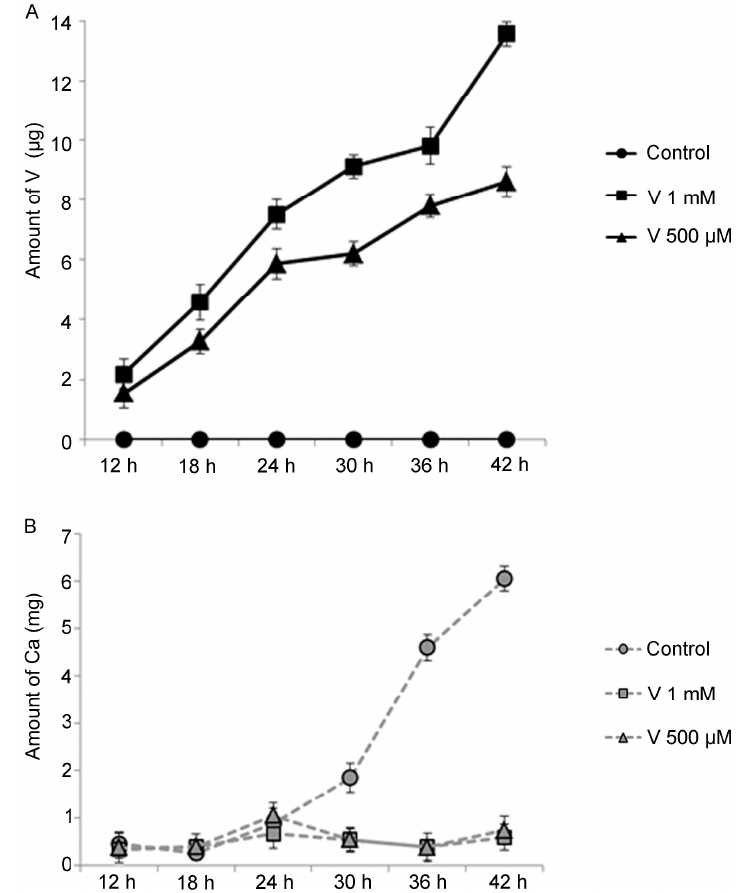
Figure 2. Amount of V and Ca incorporated during the time after 12, 18, 24, 30, 36 and 42 h of development/treatment. Embryos were cultured in 1 mM or 500 µ M of V. V ( A ) and Ca ( B ) content were detected by Inductively Coupled Plasma Mass Spectrometry (ICP-MS), determining the metal quantity in about 250,000 embryos. Experiments were performed in triplicate and data are expressed as means ± standard deviation ( n = 3 ± SD).